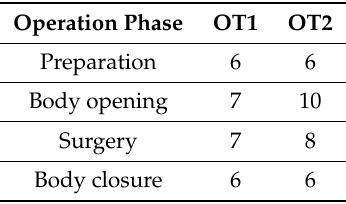
Table 3. Average medical staff presence during different phases of surgeries monitored.